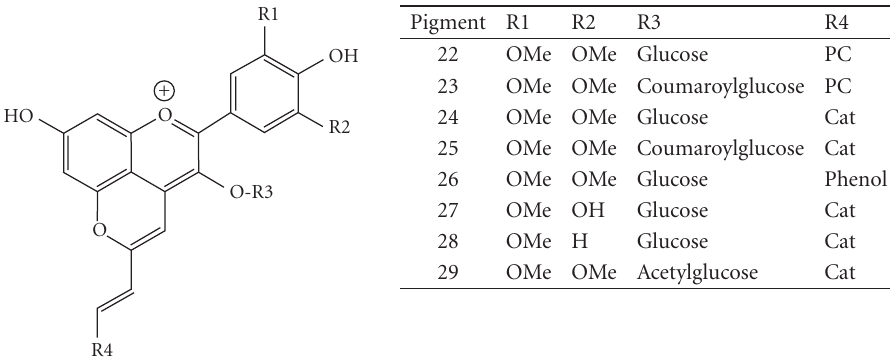
Figure 3. Portisin structures detected in Port red wine fractions (Table 2); cat = catechin; PC = procyanidin dimer.